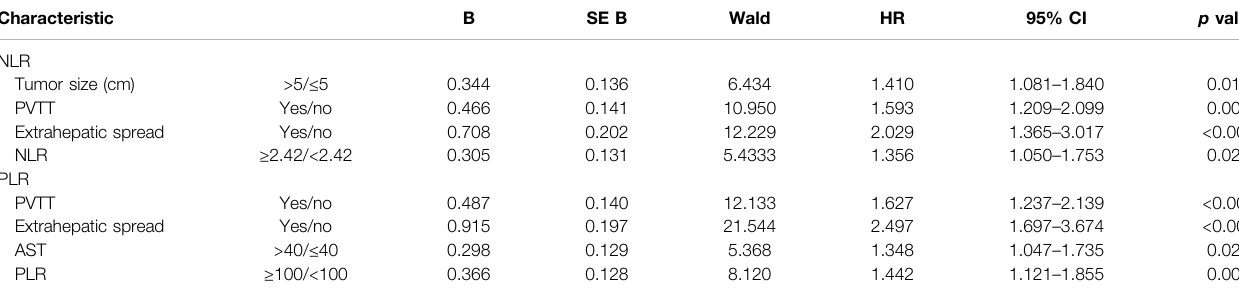
TABLE 3 | Multivariate Cox proportional hazards regression analysis of NLR and PLR with overall survival. Characteristic